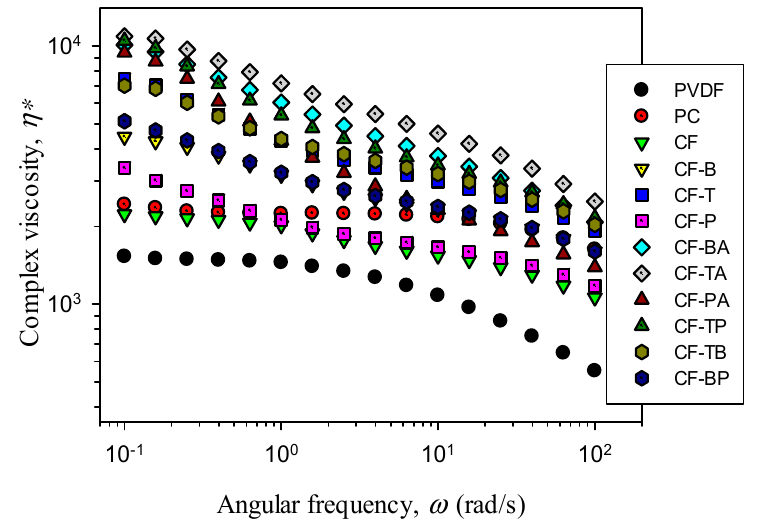
Figure 8. Complex viscosity ( η *) vs. frequency ( ω ) of the samples.